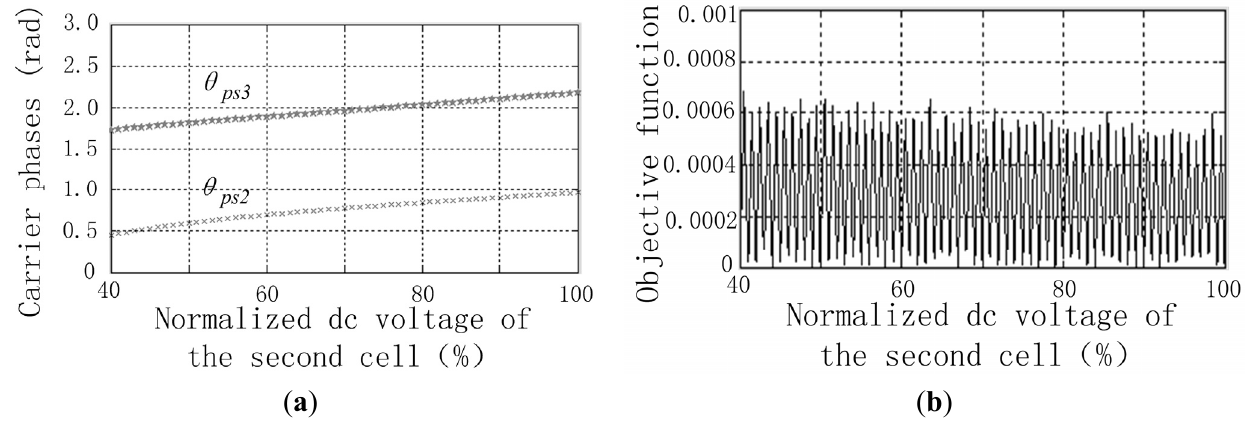
Figure 2. ( a ) Two calculated carrier phases; and ( b ) values of the objective function.